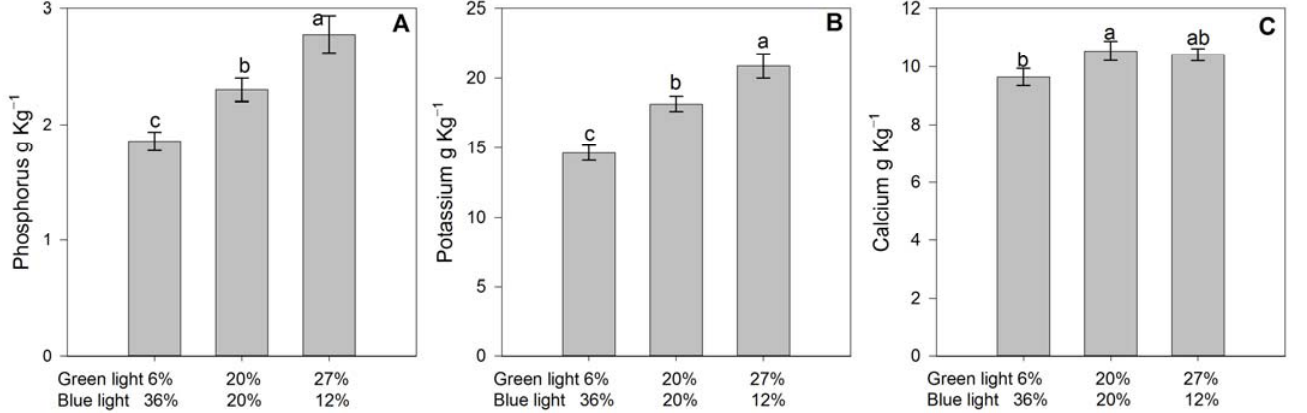
Figure 6. Effect of the green (500–600 nm) and blue (400–500 nm) light balance on leaf phosphorus ( A ), potassium ( B ) and calcium ( C ) concentration in strawberry plants grown in an indoor vertical system with LED lighting. Bars represent the standard error of the mean. Columns with different letters indicate significant differences according to Duncan’s multiple comparison test with p < 0.05.